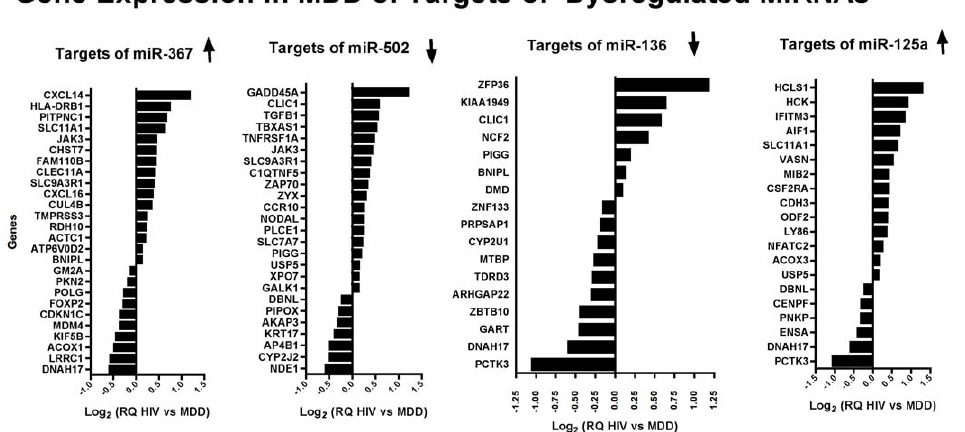
Figure 4. Targets of dysregulated miRNAs in MDD patients (mRNA relative quantification values). The gene expression values were determined using Affymetrix U133 Plus 2.0 array and compared HIV/MDD vs HIV alone from frontal cortex tissue from 6 patients in each group; one- way ANCOVA compared the two groups and were different at p , 0.05 significance are listed in Table S1. The gene expression is plotted for those with 3 9 UTR seed sequences for miRNAs that showed highly significant target bias. The direction of the dysregulation of the miRNA is indication by the arrow; for miR-367, miR-136, and miR-125a, the majority of targets are dysregulated in accordance with the miRNAs; while for miR-502, the majority of targets are anticorrelated. q or Q indicate the miRNA was upregulated or downregulated, respectively, in the array.